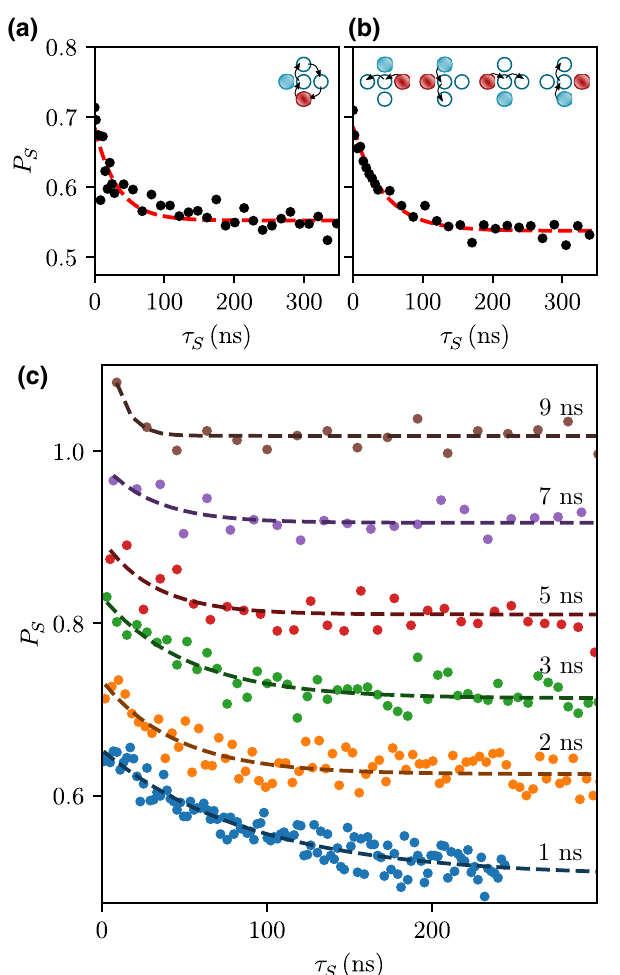
FIG. 7. Exponential spin-coherence fits of the periodically dis- placed electron. In order to extract the coherence times T coh that are discussed in the text, we fit the experimental data using a sin- gle exponential decay law. (a),(b) The same data set as in Figs. 5(c) and 5(d), respectively. The data are fitted with an exponential decay (dashed lines) with characteristic times of (a) 32 ± 7 and (b) 44 ± 4 ns (red). (c) The same data set as in Fig. 5(e). The data are fitted with an exponential decay (dashed lines) with the fol- lowing characteristic times: 91.3 ± 10 (blue), 44.8 ± 7 (orange), 51.7 ± 8 (green), 31.3 ± 9 (red), 31.2 ± 15 (purple), and 8.9 ± 9 (brown).